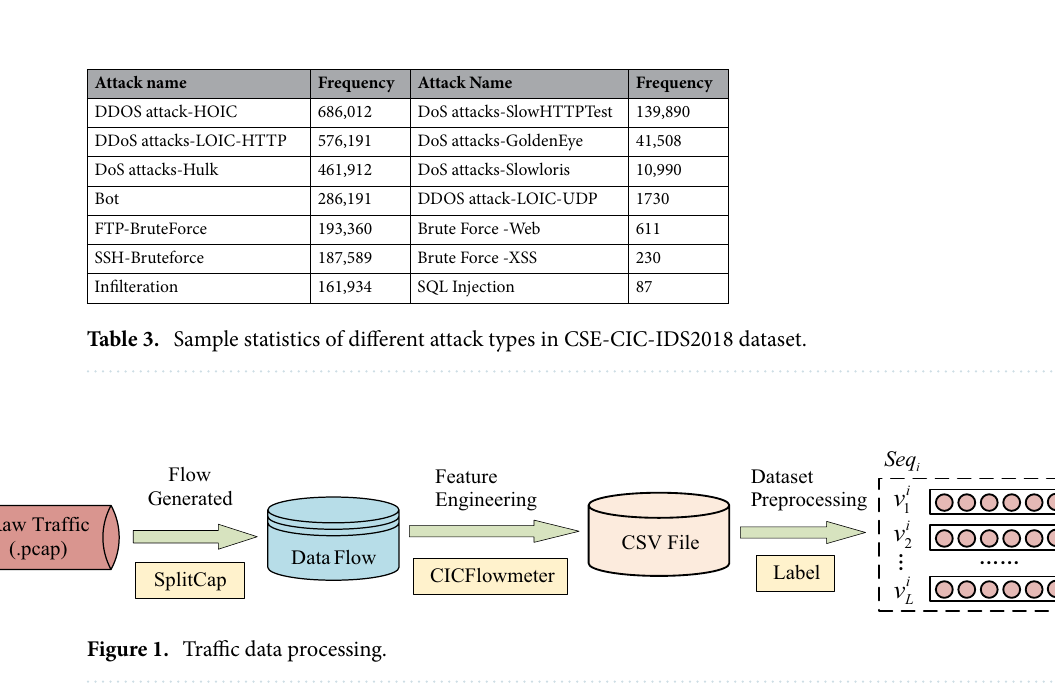
Table 2. Dataset attack type distribution in CIC-IDS2017 dataset.